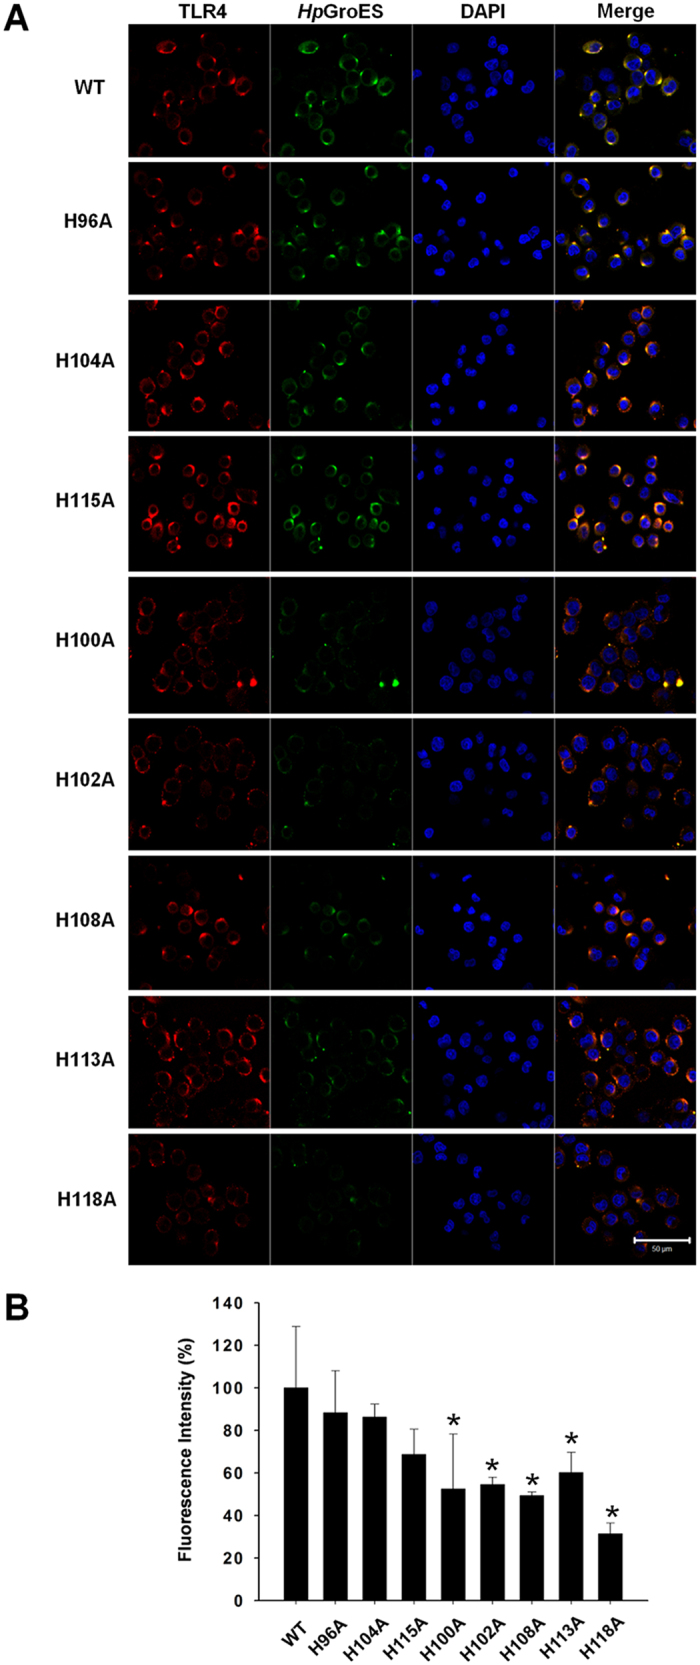
Binding abilities of WT and histidine mutant proteins to TLR4 on KATO-III cell membranes evaluated via confocal microscopy.(A) KATO-III cells were incubated for 1 h with 0.05 μM WT or histidine mutants, fixed and double-stained with anti-TLR4 (red) and anti-HpGroES antibody (green). DNA was counterstained with DAPI (blue). The merged images are presented in the right panel, and the quantified percentage of colocalization of WT and histidine mutants and TLR4 in (B). Data are representative of three independent experiments. *p < 0.05 compared to WT.